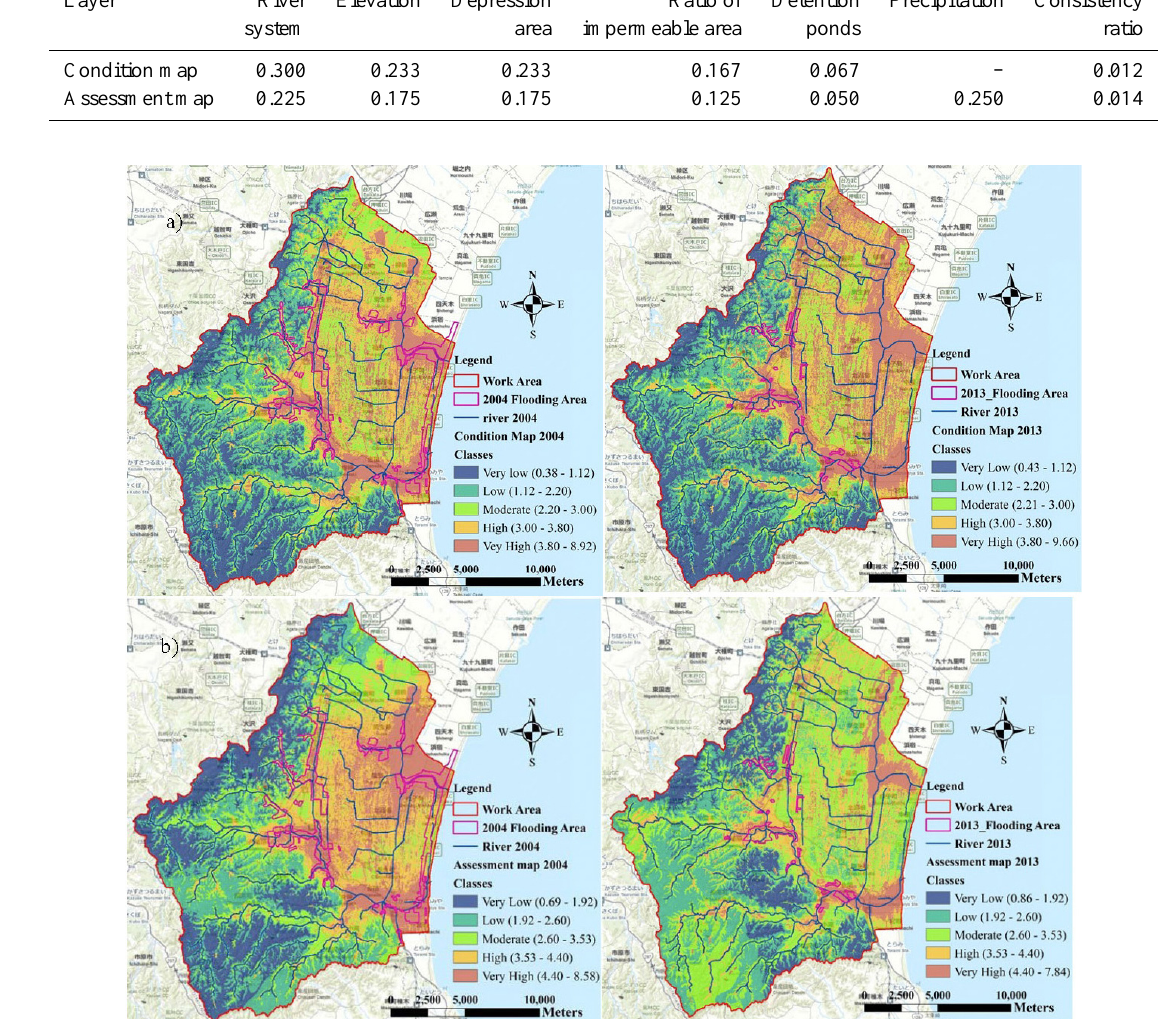
Figure 4. (a) Flood hazard condition map and (b) flood assessment map obtained by this study, for left (2004) and right (2013). The areas surrounded by pink line show the ones actually flooded (Chiba Prefecture, 2005, 2013).